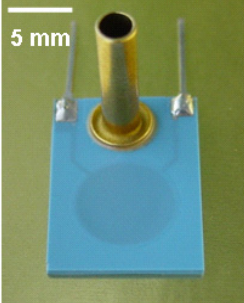
Figure 5. The capacitive ceramic pressure sensor.